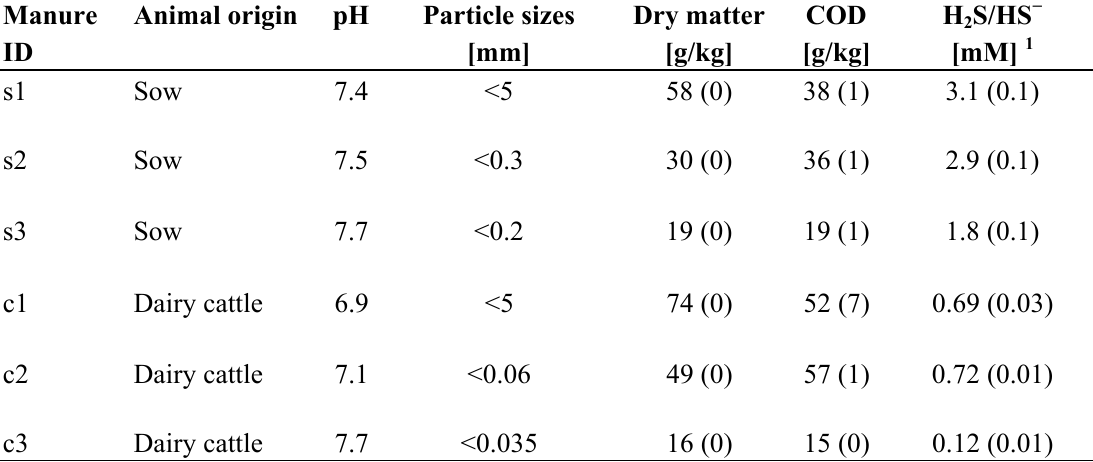
Table 1. Characteristics of untreated animal slurry batches. Standard deviations ( n ≥ 3) are indicated in brackets.